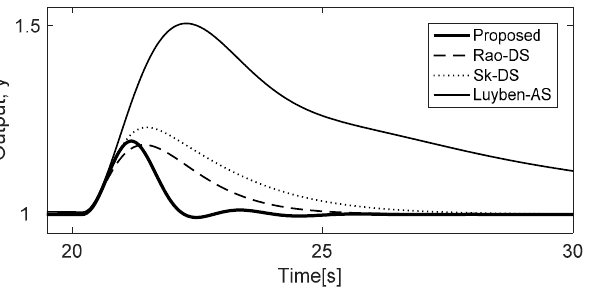
Figure 12. Regulatory responses to disturbance in IFOPTD with +10% parameter mismatch.